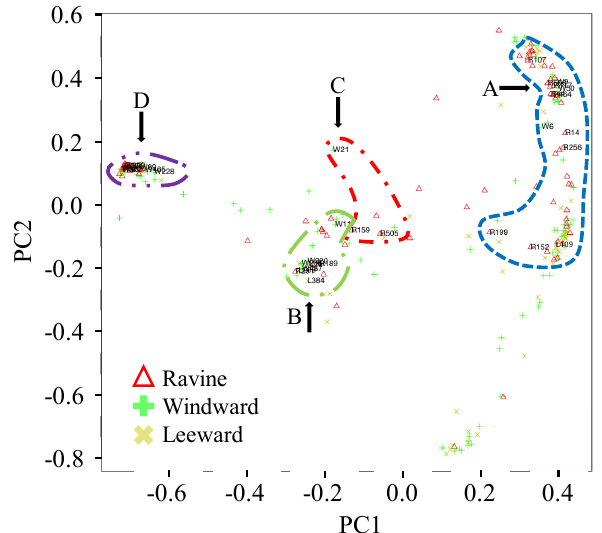
Figure 5. The PCoA plot of OTUs data in phylum Actinobac- teria and Proteobacteria in three habitats. The circle areas in A, B, C, and D are classes of α -Proteobacteria, β -Proteobacteria, γ - Proteobacteria, and Actinobacteria,